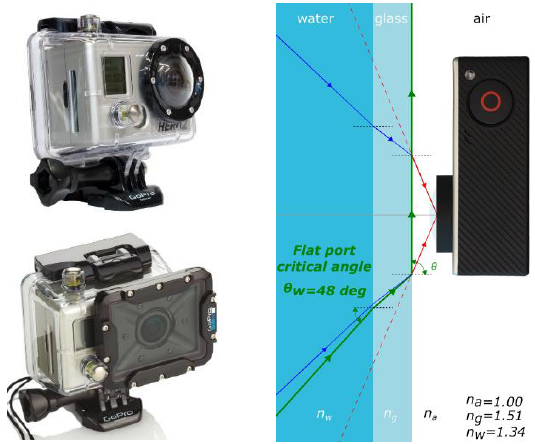
Figure 2. GOPRO HERO dome and flat ports. An early underwater housing with dome port for GOPRO HERO 1 and 2 cameras (left-up). An optional flat port replacement housing for GOPRO HERO 1 and 2 (left-down). A schematic view of the reduced field of view because of flat port critical angle (right).